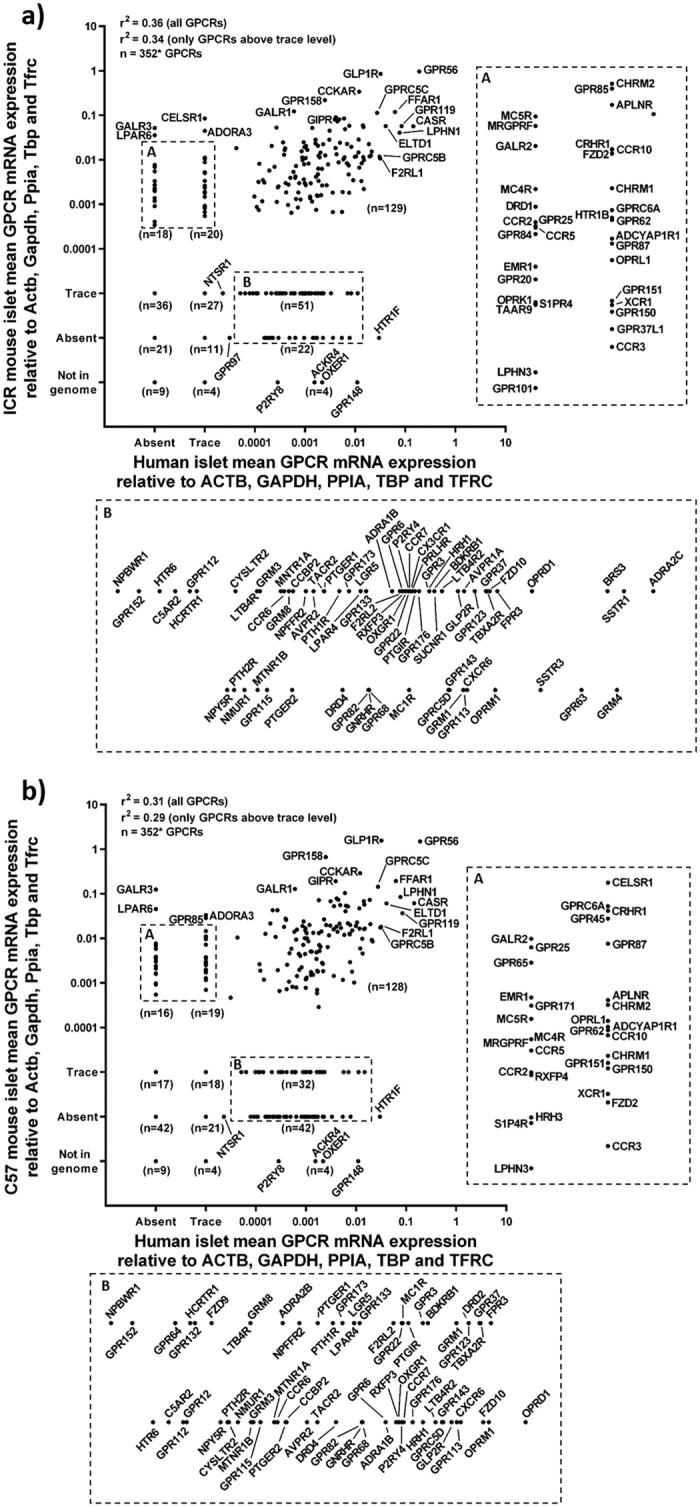
(a,b) Mean relative mRNA expression of human GPCRs in human islets and mouse GPCR orthologues in islets from ICR (a) and C57 (b) mice. Data are presented as mean GPCR mRNA expression ± SEM relative to the reference genes ACTB, GAPDH, PPIA, TBP and TFRC. Data generated using non-pooled islet RNA from four ICR and four C57 mice and four non-pooled human islet preparations. Insert panels A and B represent enlarged areas of the scatter plots, added to allow visualisation of individual GPCR mRNAs. *: excluding bitter taste receptors (TAS2Rs).